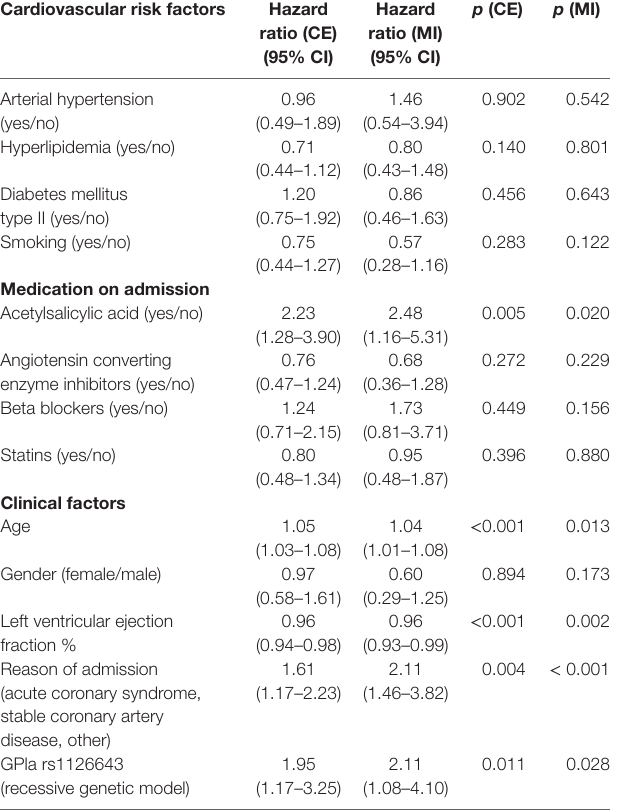
TaBle 5 | Cox regression analysis for the combined endpoint (CE) and myocardial infarction (MI) as dependent variable, rs1126643 (recessive genetic model) as independent variable, and clinical factors as covariates in the overall cohort of cardiovascular patients ( n = 870).